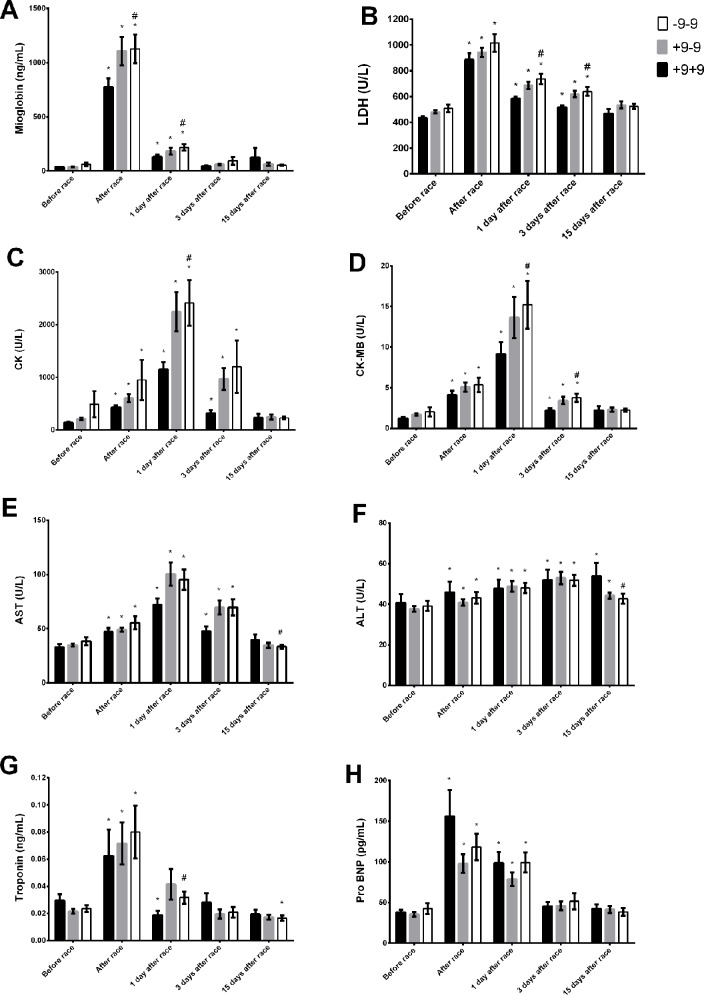
Effect of marathon on markers of muscle damage in +9+9, −9+9 and −9/−9 BDKRB2 genotypes. The markers of muscle damage evaluated were myoglobin (A); lactate dehydrogenase, LDH, (B); creatine kinase, CK (C); CK-MB (D); aspartate transaminase, AST (E); alanine transaminase, ALT (F); troponin (G); brain natriuretic peptide, Pro BNP (H). The values are presented as of mean ± SEM of 16–39 runners. *P < 0.05 vs before; #P < 0.05 −9/−9 vs +9+9 genotype.